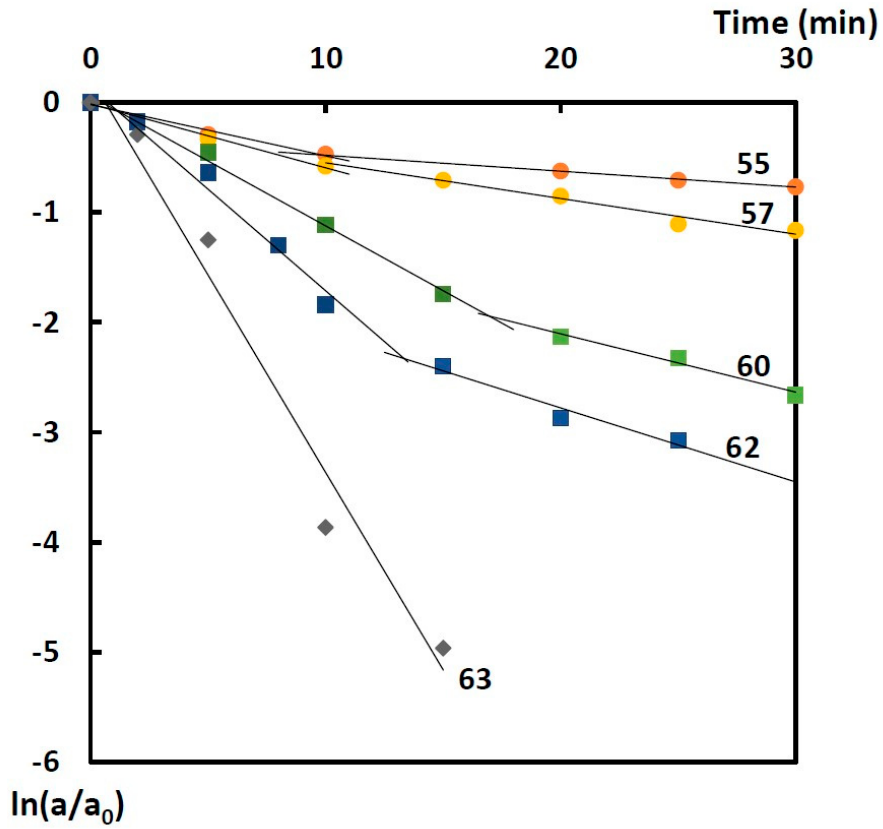
Figure 3. Semi-log plot showing the time-dependence for the thermal inactivation of BChE in buffer. Figure 3. Semi ‐ log plot showing the time ‐ dependence for the thermal inactivation of BChE in Numbers on curves correspond to temperature values ( ◦ buffer. Numbers on curves correspond to temperature values (°C).